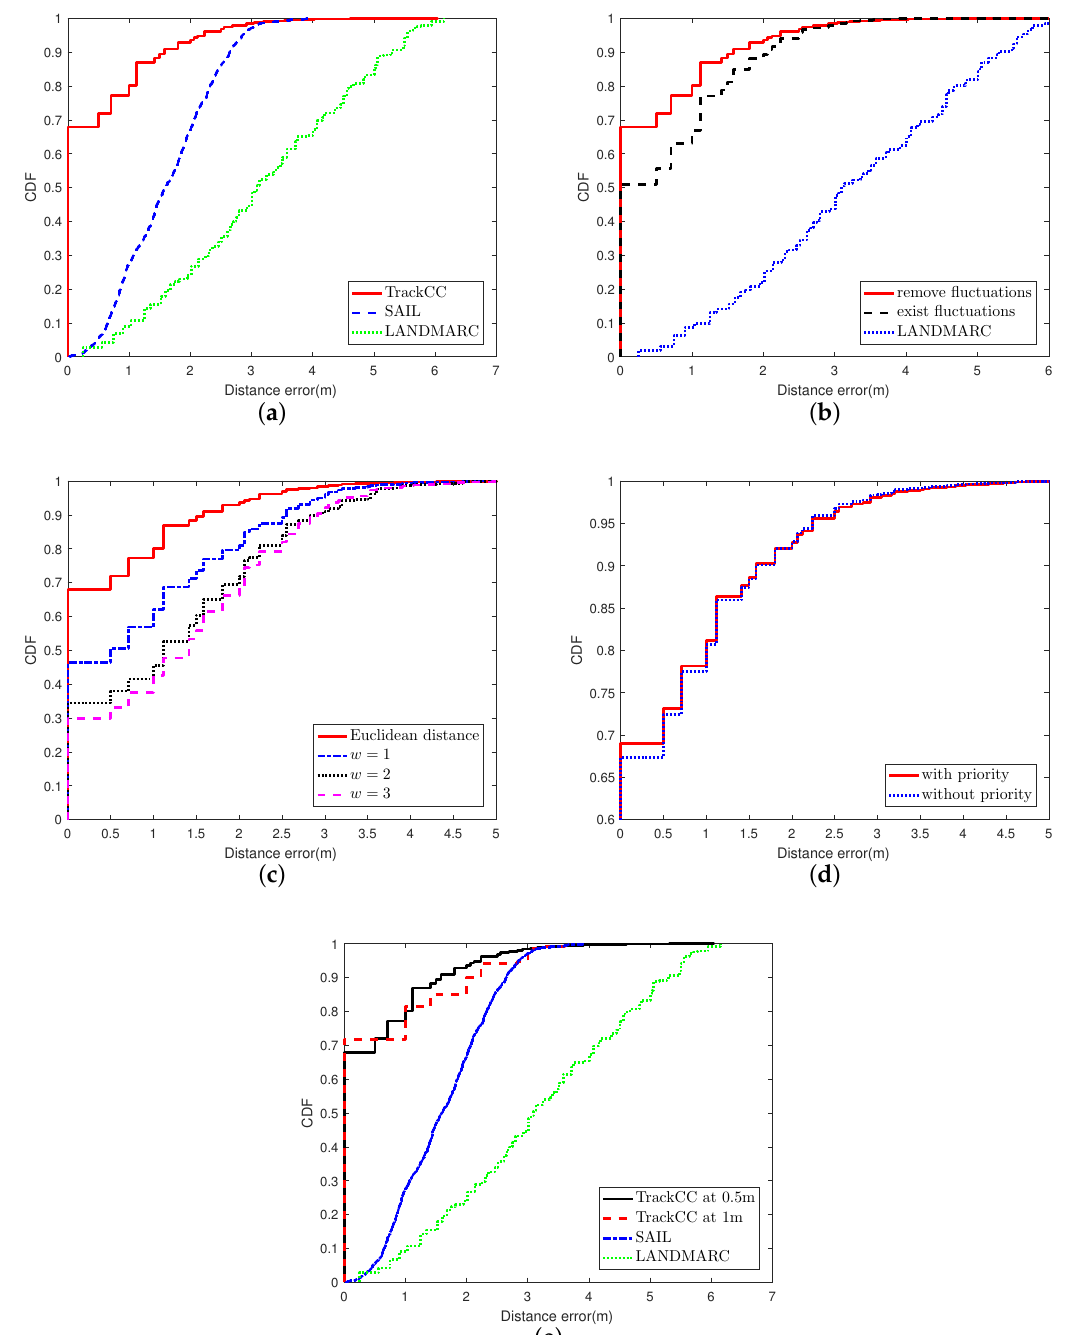
Figure 6. The performance evaluation of TrackCC in the case of line-of-sight (LOS). ( a ) the performance in the case of LOS; ( b ) fluctuation removal; ( c ) similarity calculation; ( d ) priority conversion rule; ( e ) expand grid to the size of 1 m × 1